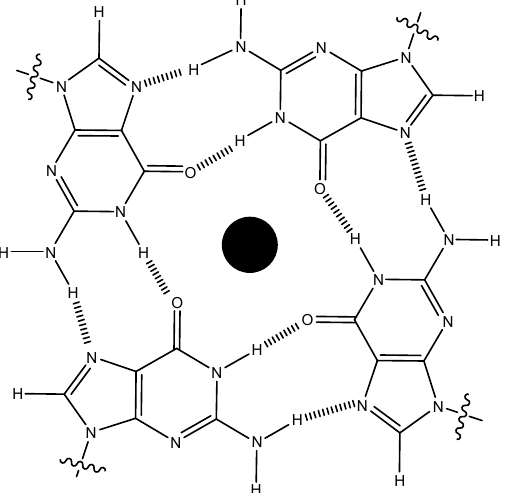
Figure 1. The arrangement of guanine bases in a G-tetrad. The cavity in the middle is occupied by the metal